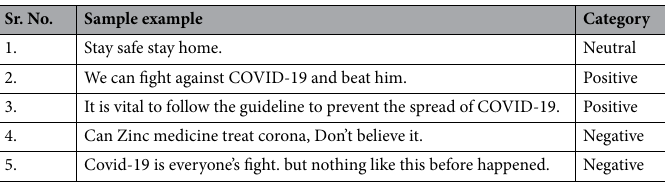
Table 2. Some sample example from Covid-19 data collection.